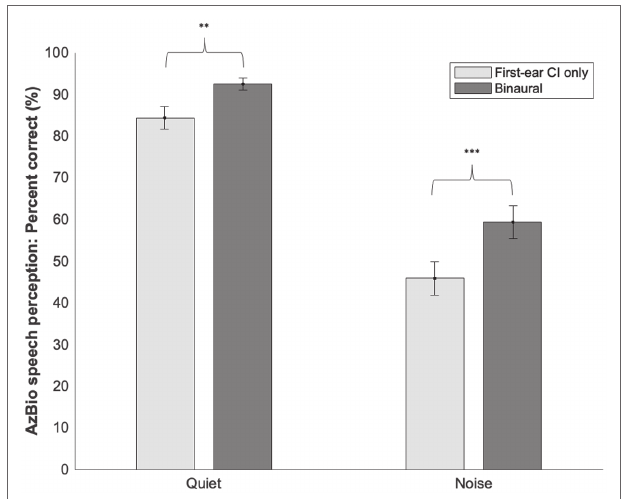
FIGURE 2 | Means and SD’s of first-ear CI only and binaural speech perception scores in quiet and noise. Significant differences were noted between a first-ear CI only and binaural configuration in both quiet and noise. ** ≤ 0.01, *** ≤